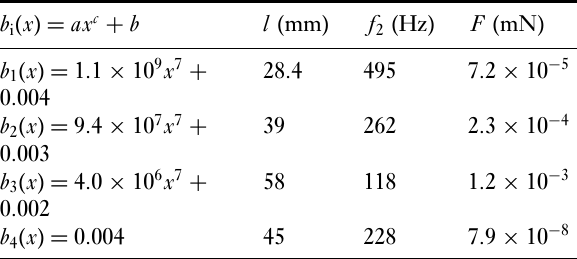
Figure 12 The contour plot of stress. Table 2 Results of optimisation to caudal fins